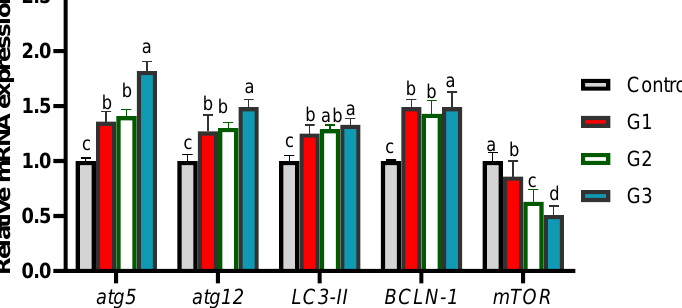
Figure 3. Analysis of quantitative reverse transcription polymerase chain reaction of autophagy ( atg5 and atg12 ), mechanistic target of rapamycin ( mtor ), beclin-1 ( bclN-1 ), and microtubule-associated proteins 1A/1B light chain ( lc3-II ) encoding genes in fish fed diets fortified with Thy and/or ThQ. Results are expressed as means ± SEM. Columns with various letters represent significant variations ( p < 0.05). Control: tilapia fed basal diets without any supplementations, G1: tilapia fed basal diets with thymol (Thy) supplementation at a concentration of 200 mg/kg diet, G2: tilapia fed basal diets with thymoquinone (ThQ) supplementation at a concentration of 200 mg/kg diet and G3: tilapia fed basal diets with Thy/ThQ supplementation at a concentration of 200 mg/kg diet each.